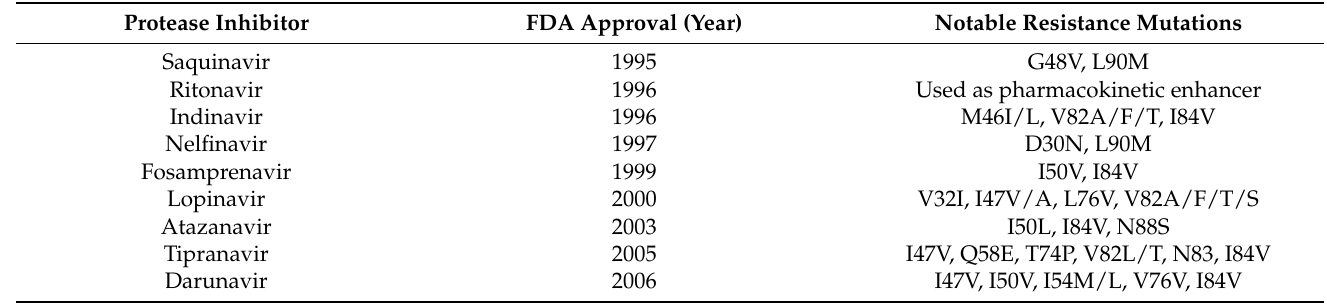
Table 2. List of FDA-approved HIV-1 protease inhibitors. Mutations are indicated using the single letter code for amino acids.